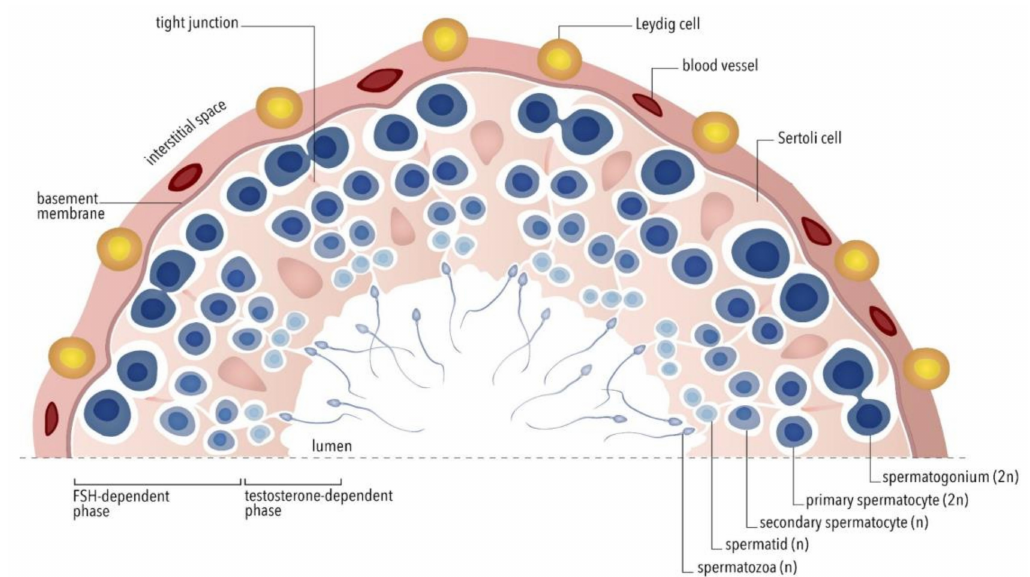
Figure 1. Schematic representation of a hemi-section of a seminiferous tubule. From the basal membrane to the lumen, spermatogenesis stages are reported up to the mature spermatozoa. This complex process is regulated synergistically by follicle-stimulating hormone (FSH) acting on Sertoli cells and by intra-testicular testosterone, produced by Leydig cells under luteinizing hormone (LH) stimulus. (FSH = follicle-stimulating hormone; n = haploid cell; 2n = diploid